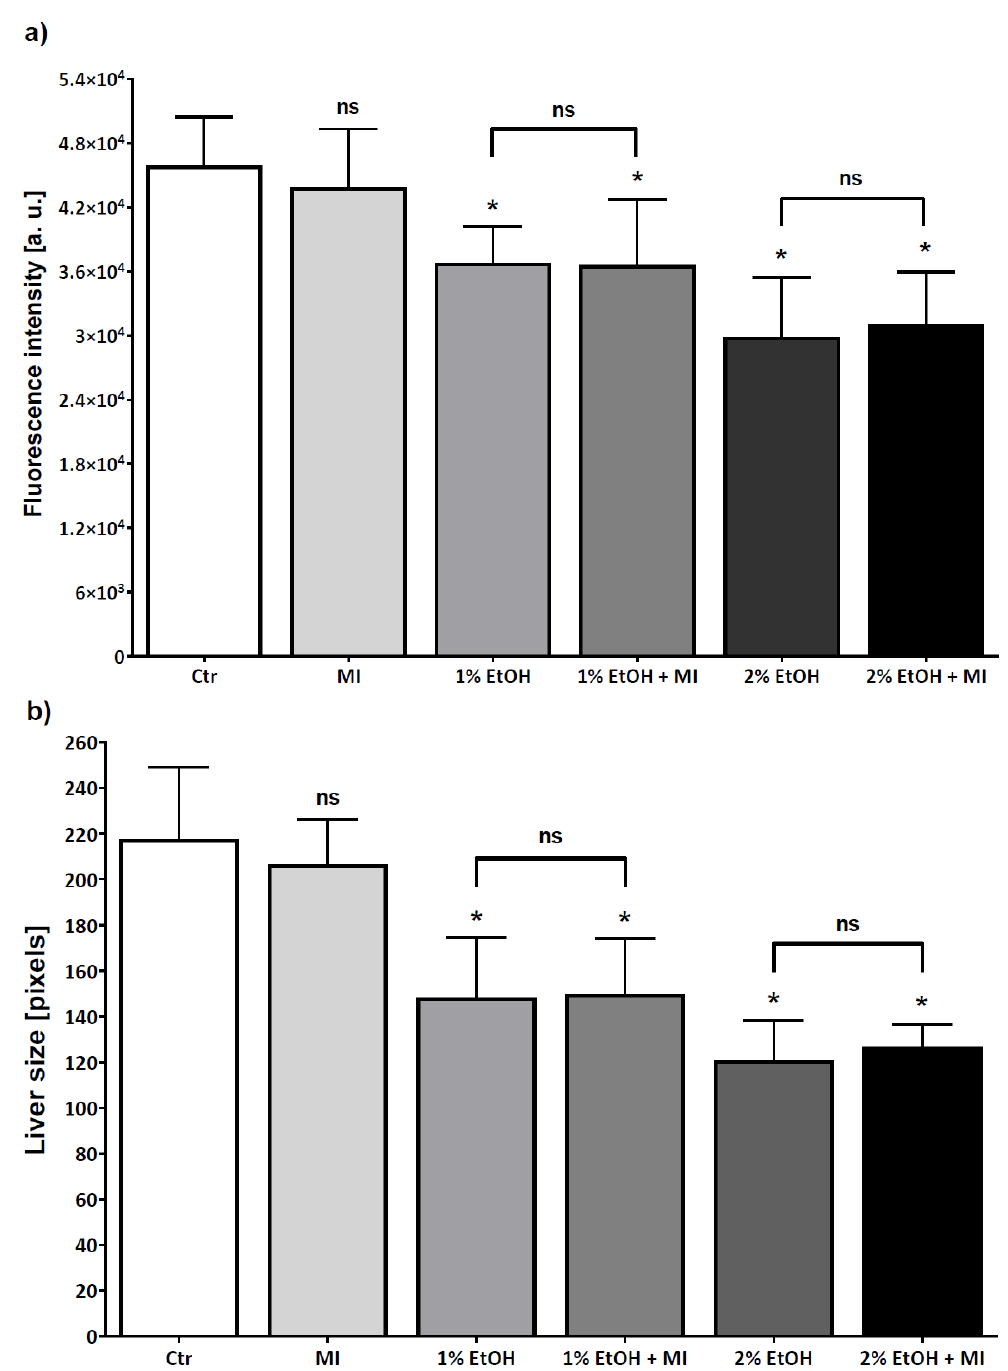
Figure 7. MI protective effect shown by the fluorescence intensity ( a ) and size ( b ) of the liver of zebrafish larvae livers. Results were analysed by the t -test in GraphPad Prism 6. All groups were compared with the control group-Ctr. Additionally, groups treated with 1% and 2% of ethanol (EtOH) were compared with groups treated with 1% of ethanol with 5 mg/mL of myo-inositol (MI)and treated with 2% of ethanol with 5 mg/mL of MI, respectively. * p < 0.0001; ns = nonsignificant.